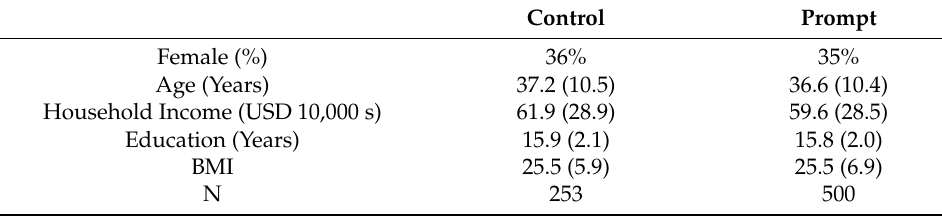
Table 1. Demographic characteristics of the sample population a .